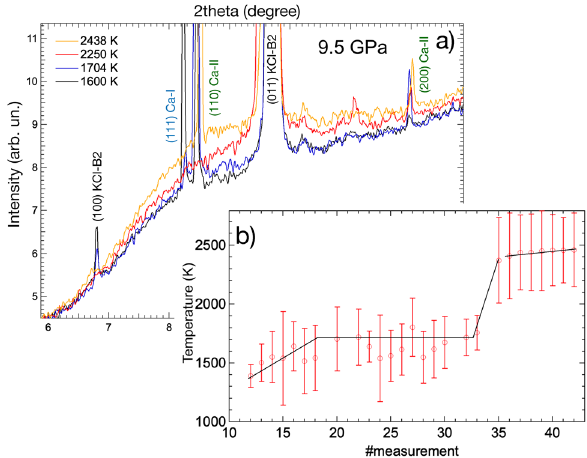
Figure 2. ( a ) Integrated XRD patterns at different temperatures at 9.5 GPa. The onset of melting, characterized by the first appearance of diffuse signal, is observed at 1704 K (blue pattern). The diffuse scattering increases with the rising temperature, up to a maximum of 2438 K (orange pattern), where most of the sample is melted. ( b ) Evolution of the average T during the ramp. The black lines have been drawn as guides for the